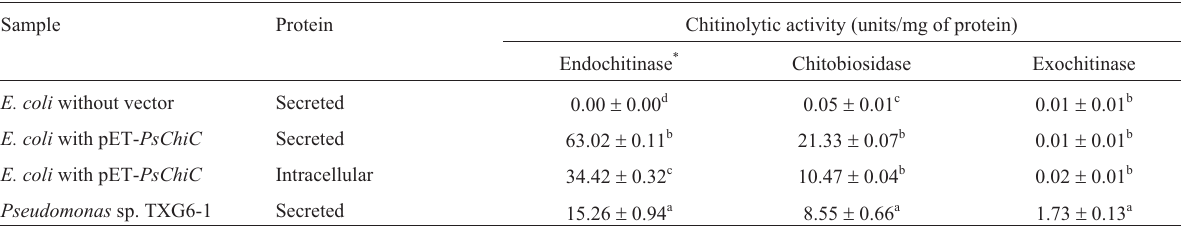
Table 1 - Chitinolytic activities of Pseudomonas chitinase C ( PsChiC ) expressed in E. coli . Sample Protein Chitinolytic activity (units/mg of protein)